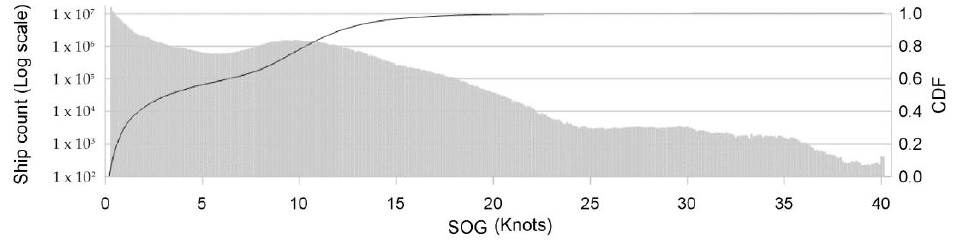
Figure 8. Distribution by SOG in Korean coastal waters.